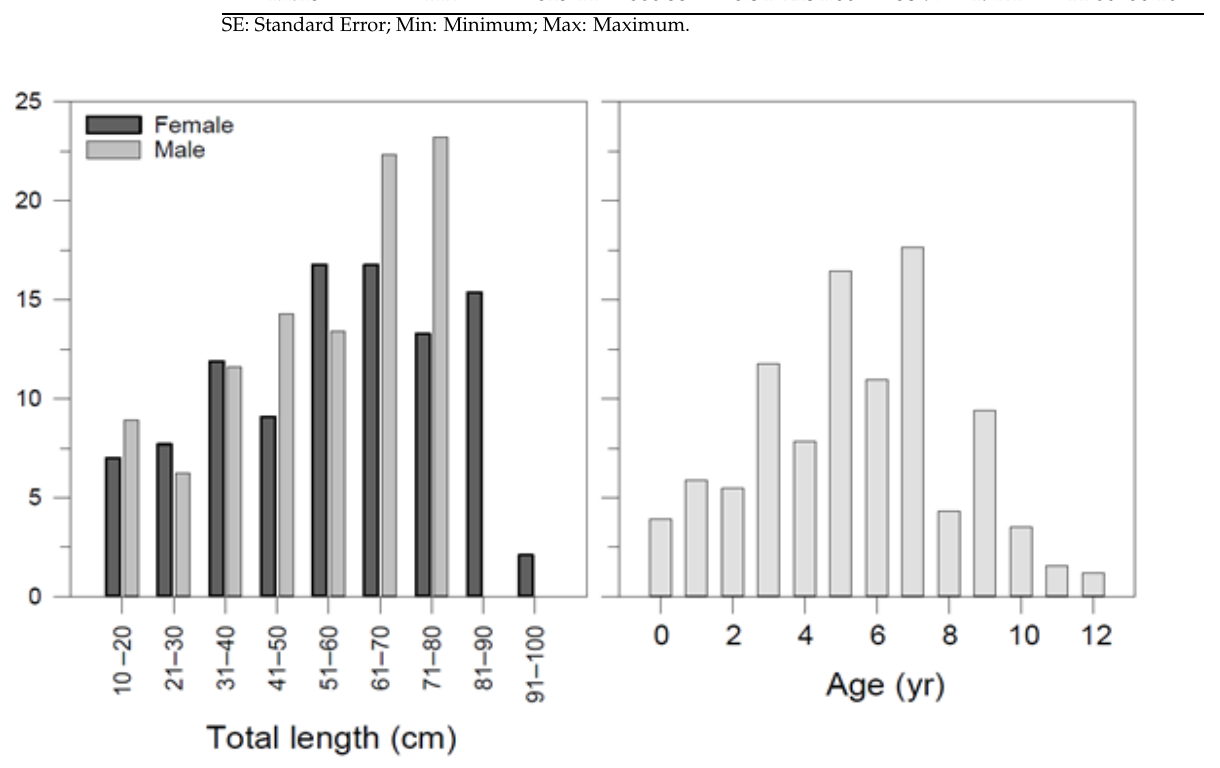
Figure 3. Frequency distribution of Dipturus oxyrinchus inhabiting the Northeastern Mediterranean Sea, according to their total length and age.